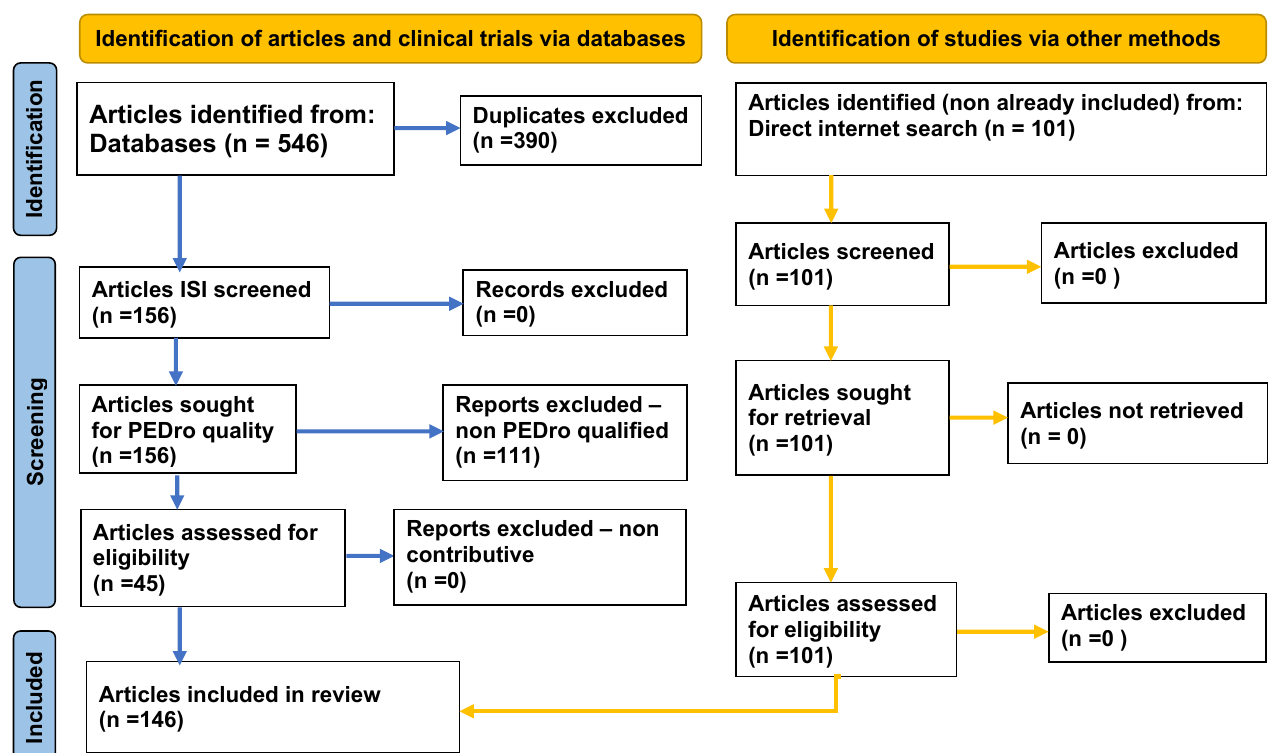
Figure 1. PRISMA flow diagram adapted to our study.